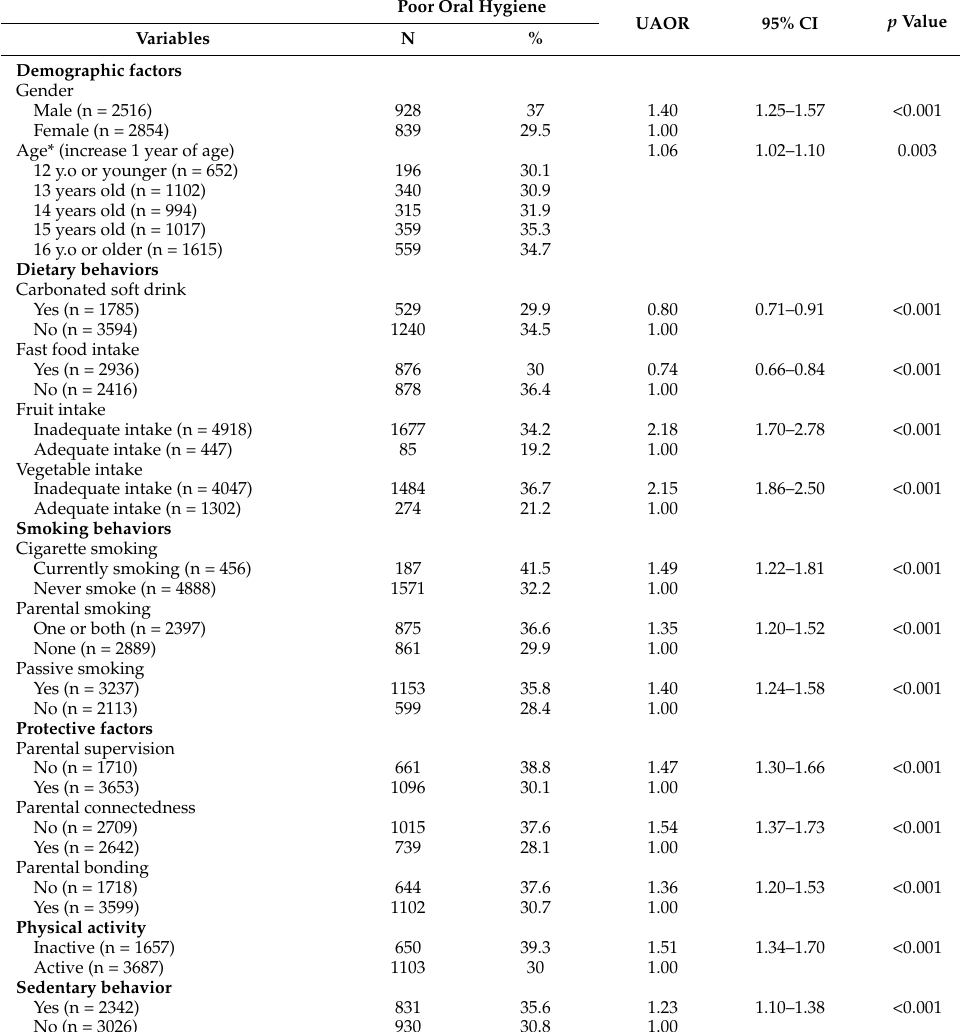
Table 1. Sample characteristics associated with poor oral hygiene among school going students in Mongolia (univariable logistic